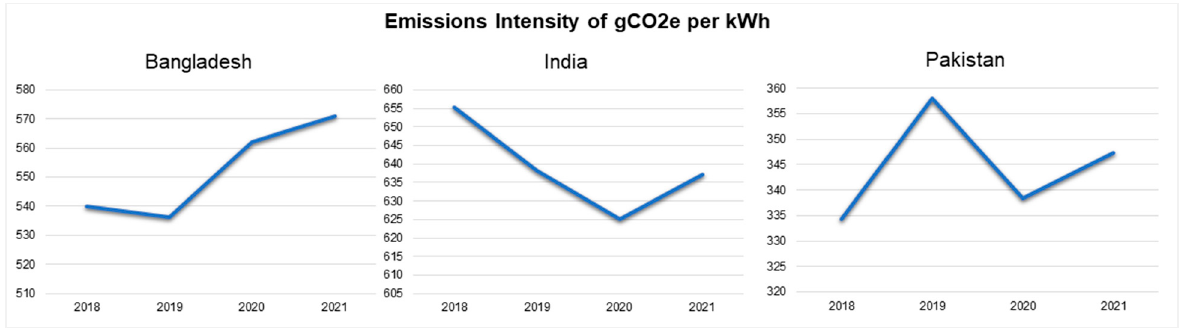
Figure 2. Emissions intensity of CO 2 per kWh (2018–2021) [43].